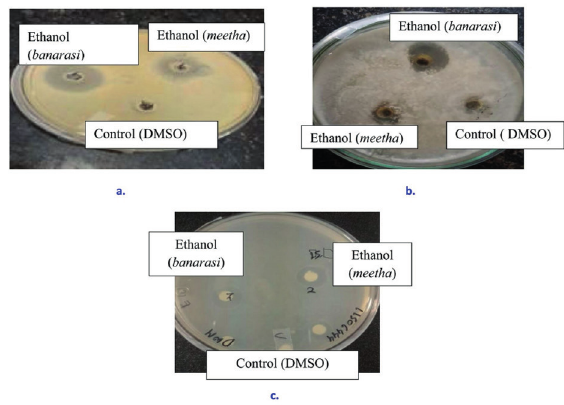
Figure 1 - Zone of inhibition (mm) of ethanolic extracts on a . Bacillus subtilis , b . E. coli , c . Saccharomyces cerevisiae